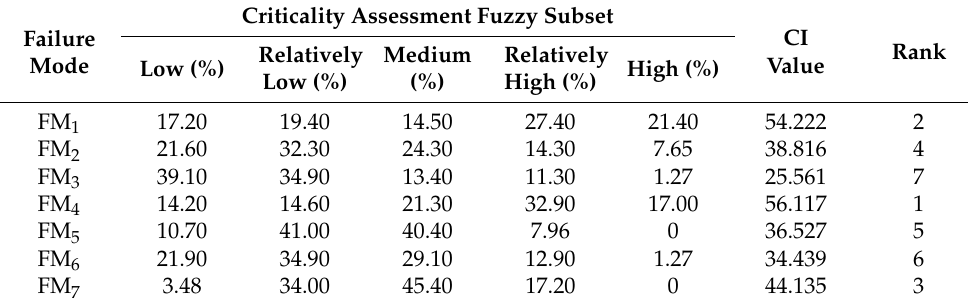
Table 13. Failure mode risk assessment result.